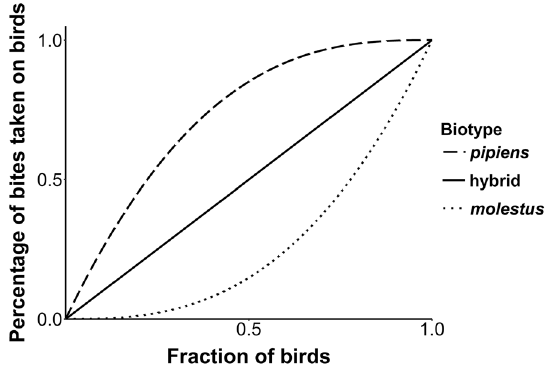
Figure 1. Relation between fraction of birds in the host population and the percentage of bites taken on birds. Percentage of mosquito bites taken on birds by biotype pipiens , biotype molestus , and hybrids, as a function of the fraction of bird hosts in the total host